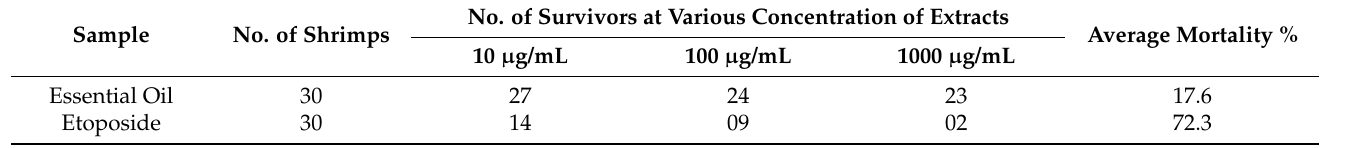
Table 3. Brine shrimp lethality assay for O. basilicum essential oil